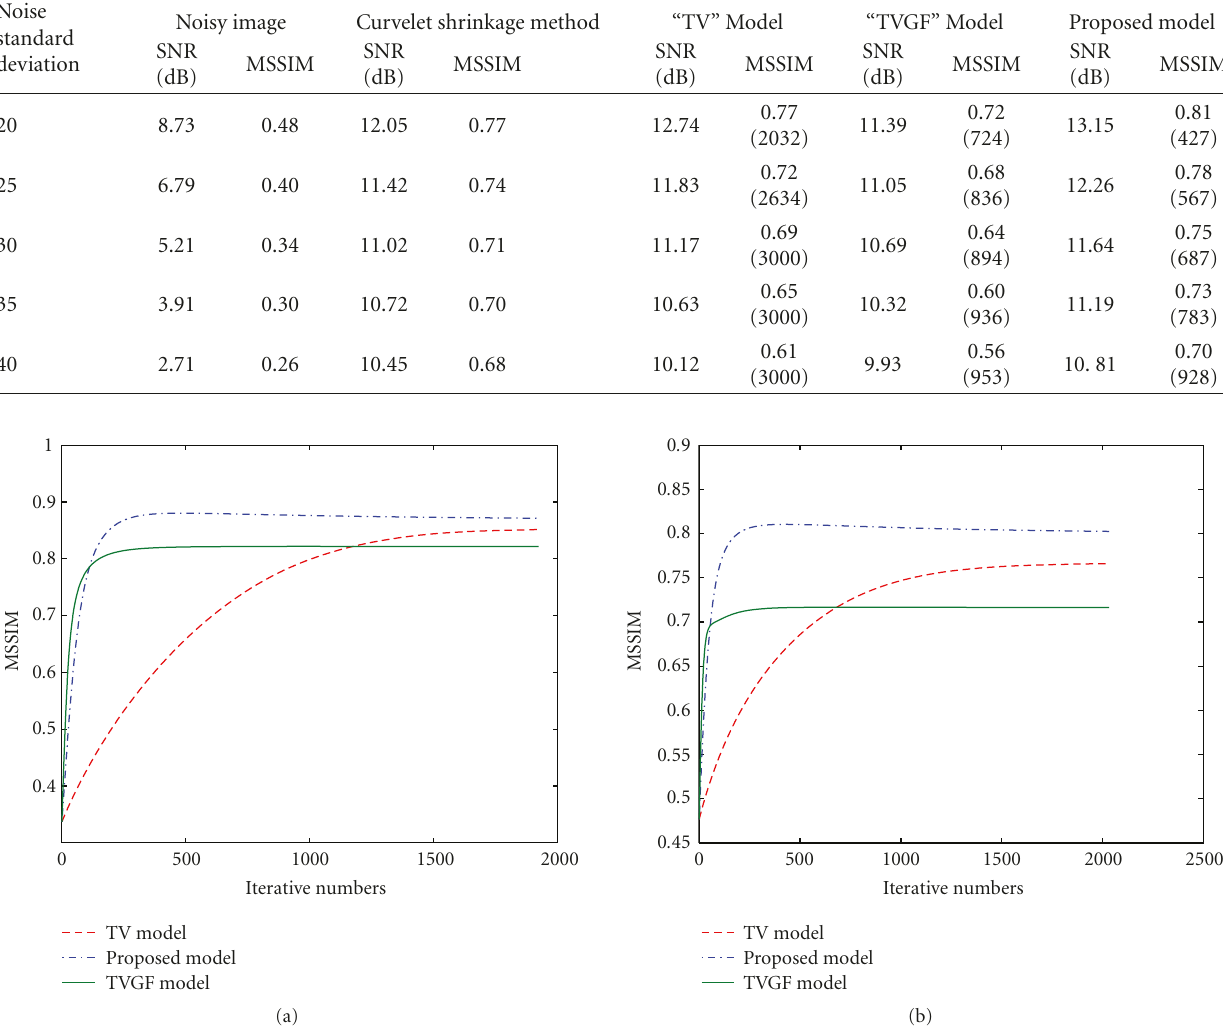
Table 2: The SNR, MSSIM of the restored “Barbara” images by using four models. The numbers in the bracket under the “MSSIM” column refer to the total iteration number of the algorithm.